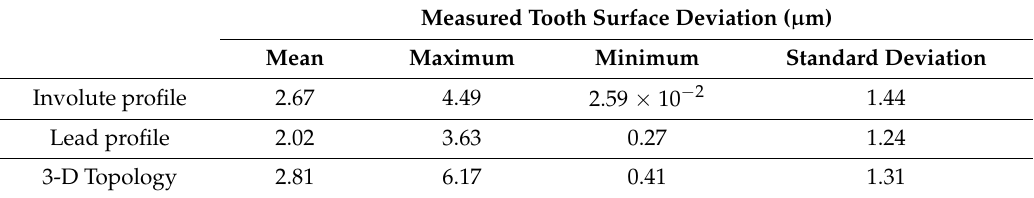
Figure 13. Spur gear tooth surface: ( a ) Topology of the gear tooth surface in 10 × 5 grids; ( b ) deviation of the tooth surface topology measured by the projection moiré system from the CMM method.